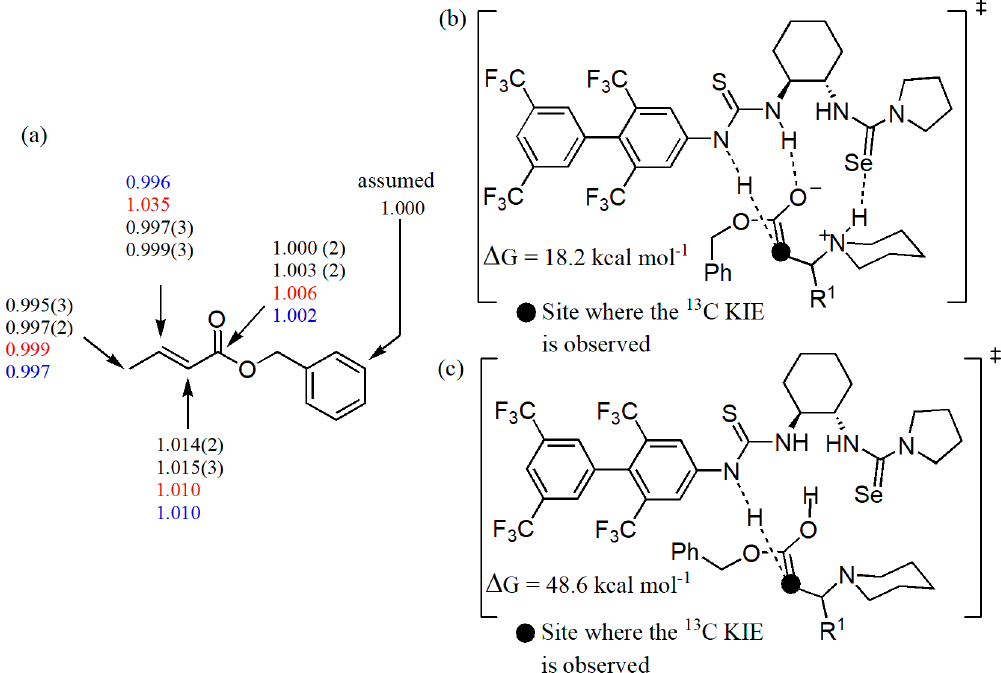
Figure 28. Synthesis of amino esters 40 from compounds 38 . ( a ) Observed KIEs (in black) and calculated KIEs for the C − N bond-forming transition structure R-TS C − N (in red) and for the direct C-protonation transition structure R-TS C--prot (in blue) and the possible transition states according to the experimental KIEs; ( b ) catalyst-mediated C-protonation and ( c ) catalyst-mediated tautomerization [63].